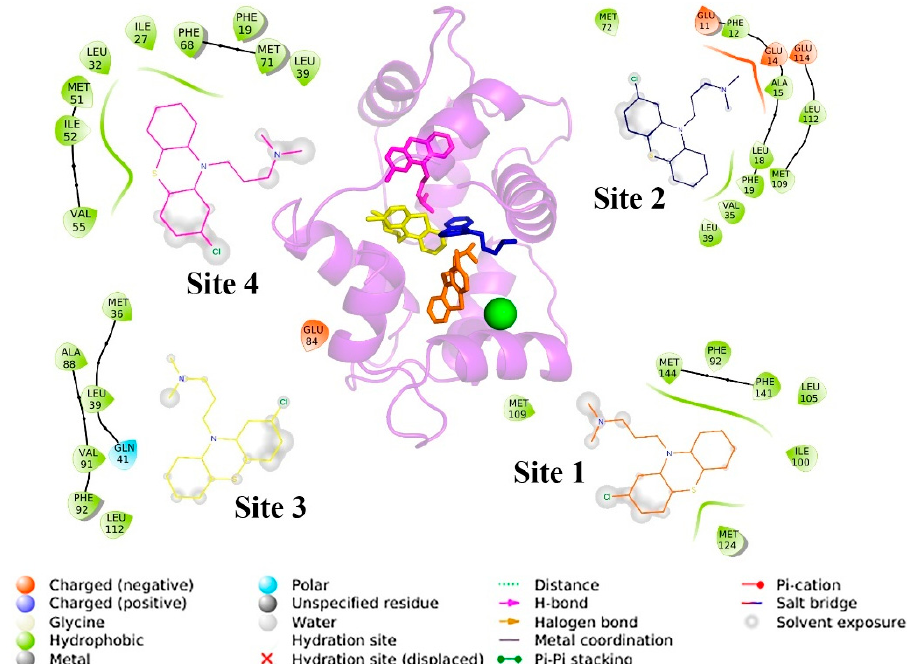
Figure 2. Analysis of the CaM-CPZ complex (1:4). In the center, CaM is shown in purple cartoons with 4 CPZs (CPZ-1; orange stickers), (CPZ-2; blue stickers), (CPZ-3; yellow stickers), and (CPZ-4; purple stickers); and in the green sphere, position 124 is where the fluorophore of the biosensor is attached. In the periphery, the analysis of the interactions with the residues is at 4 Å.